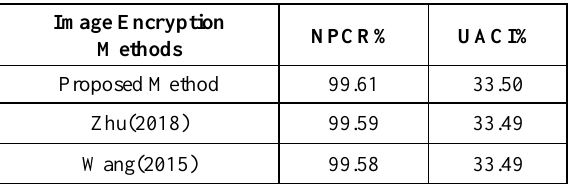
Table 2. Comparing the result of plaintext average test between the proposed method and the other